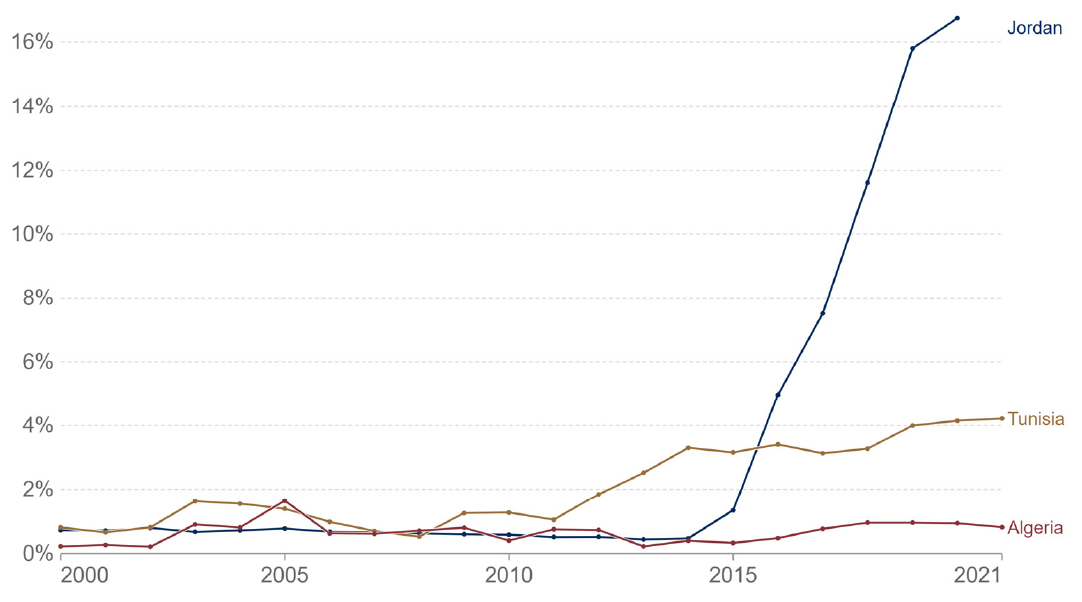
Figure 3. Share of electricity production from renewables for Tunisia, Algeria and Jordan. Source: Our World in Data based on BP Statistical Review of World Energy. OurWorldInData.org/energy, CC BY.